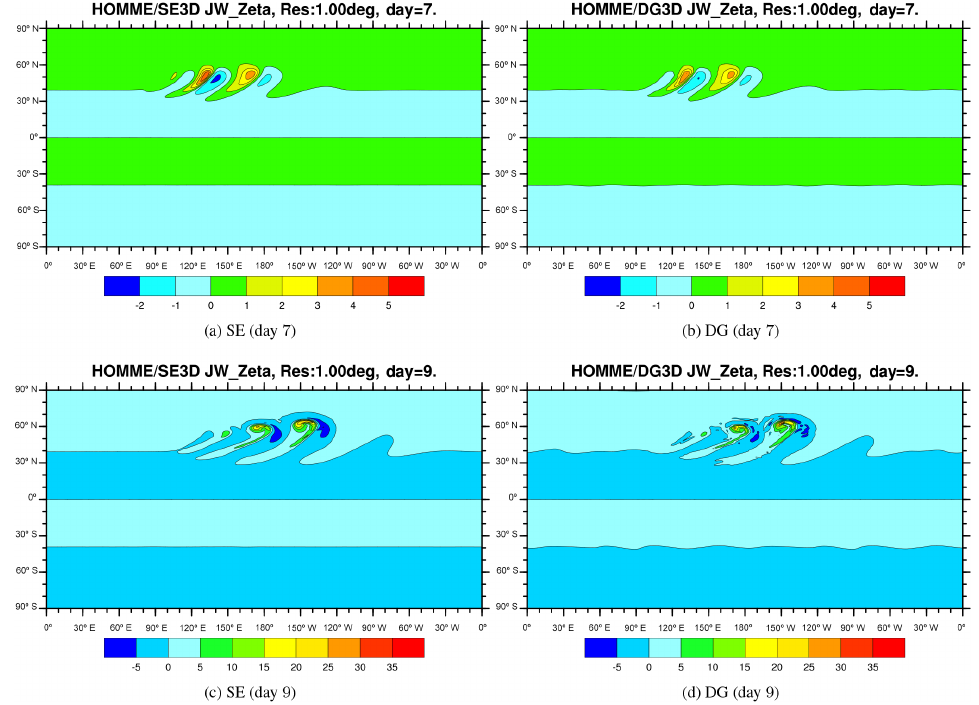
Figure 4. Vorticity at day 7 and 9 for the HOMME-SE (a, c) and HOMME-DG (b, d) code for the Jablonowski–Williamson baroclinic wave instability test case. Both methods used 1 ◦ resolution at the Equator (nlev = 26; SE: np = 4, n e = 30; DG: np = 6, n e =